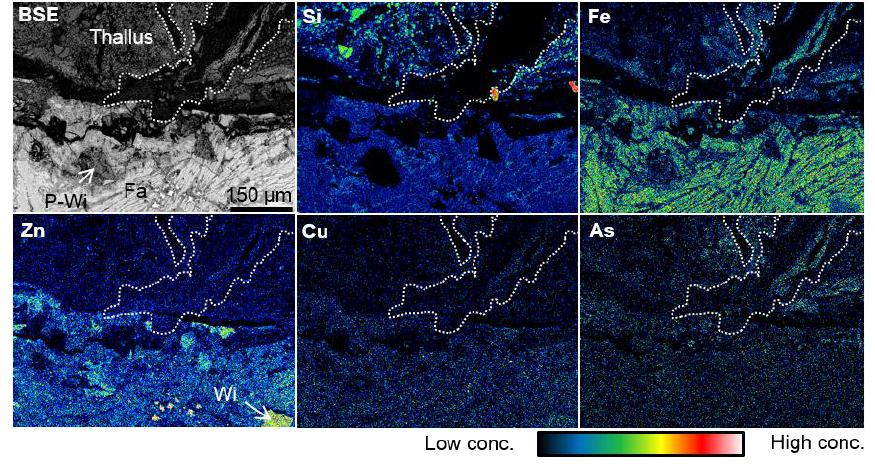
Figure 5. A back-scattered electron image and the elemental maps of a lichen-slag interface obtained by SEM-EDS. The broken lines indicate thallus. Fa: fayalite; P-Wi: pseudomorph of